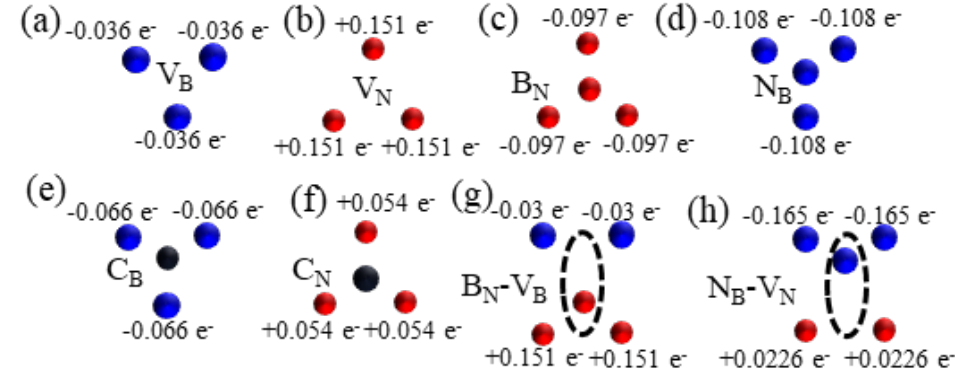
Figure 6. Phonon band structure of hBN monolayer with different defects.